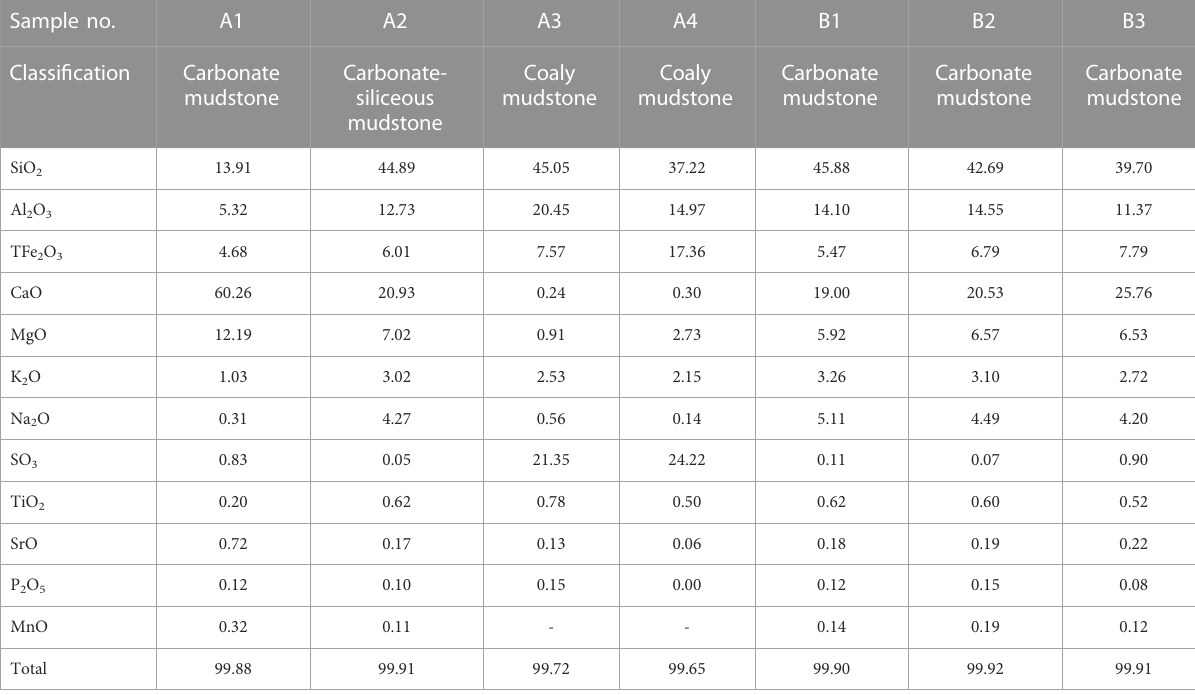
TABLE 2 Major element data of the rock samples from the Huai Hin Lat Formation. Sample